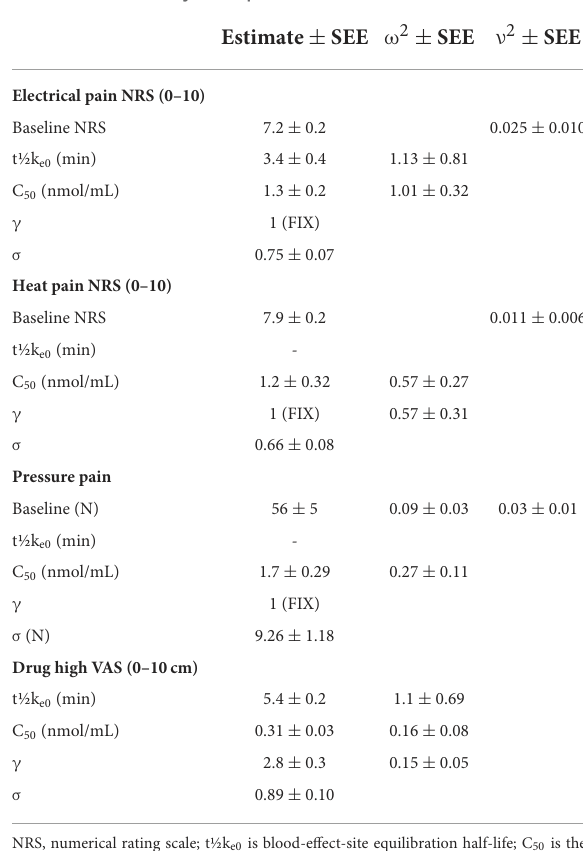
sublingually ( n = 15) or on the buccal mucosa ( n = 5). TABLE 1 Pharmacodynamic parameter